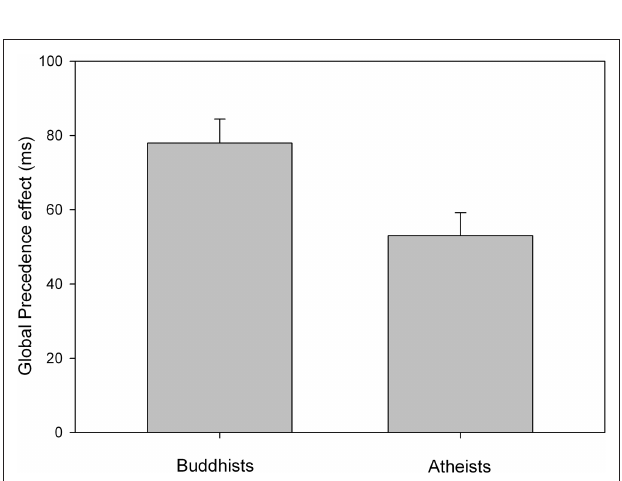
Figure 2 | Mean global-precedence effect for Atheists and Buddhists. Vertical capped lines atop bars indicate standard error of the